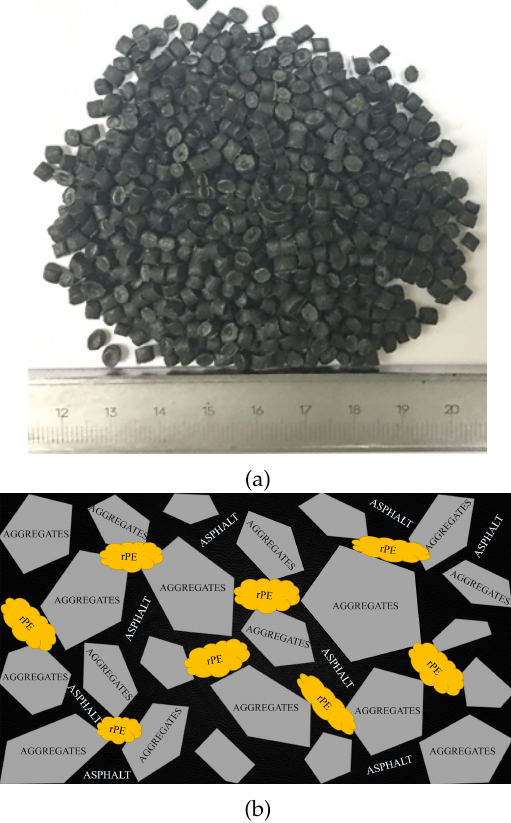
Fig. 1. Recycling Polyethylene additive: (a) Shape and color; (b) Reaction